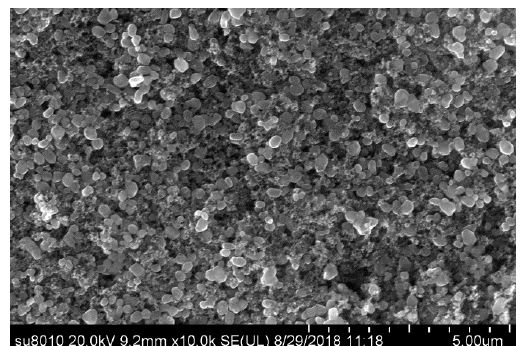
Figure 2. SEM micrographs of the TiO 2 nanoparticles on the glass.